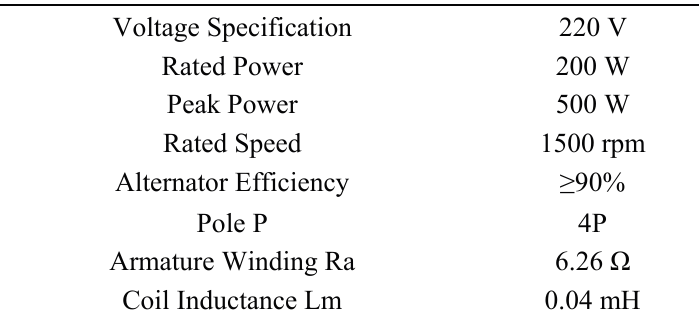
Table 2. Generator